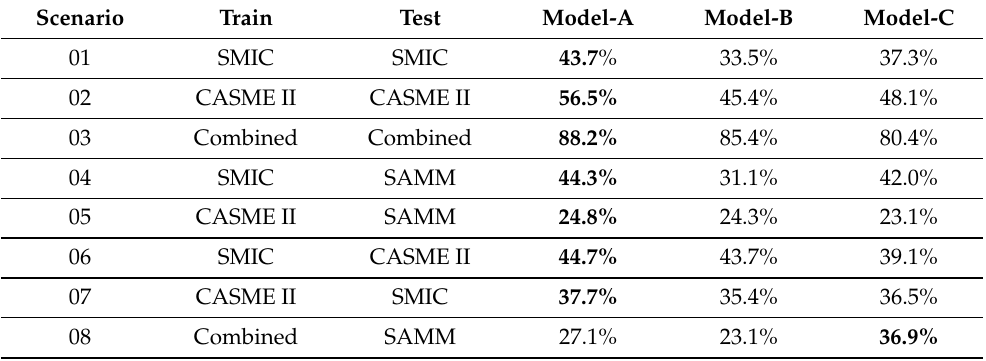
Table 4. Accuracy comparison of the three models across all eight evaluation